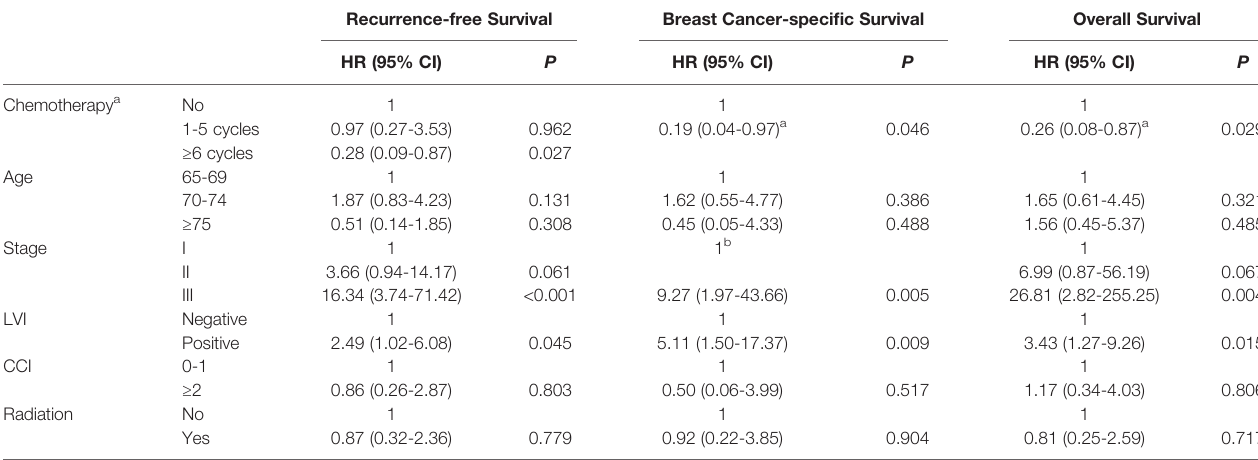
TABLE 4 | Multivariate Cox proportional hazard model of factors associated with survival outcomes in 177